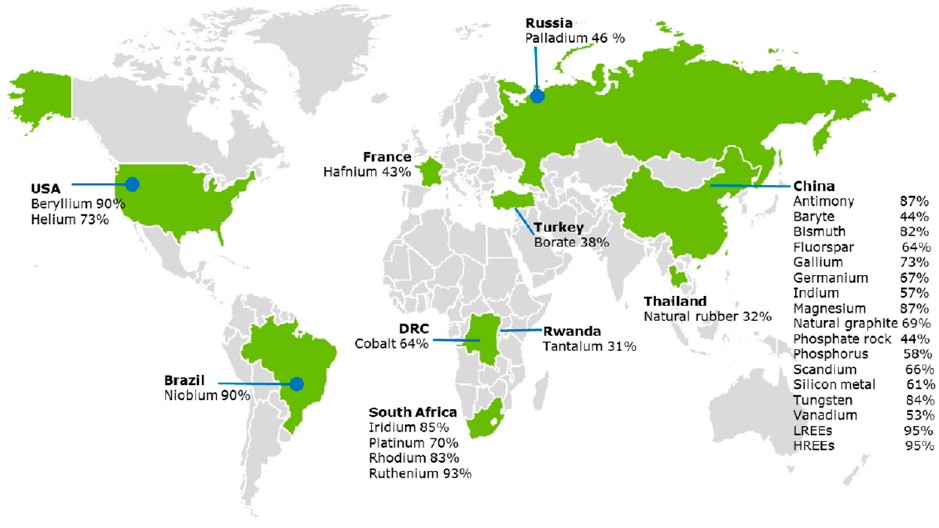
Figure 2. Countries accounting for largest share of the global supply of critical raw materials [7].